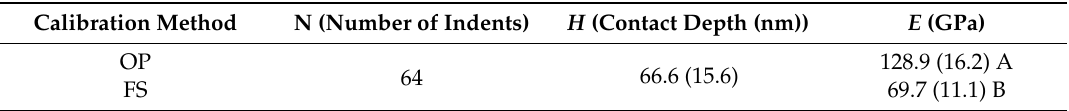
Table 1. Calibration test results.